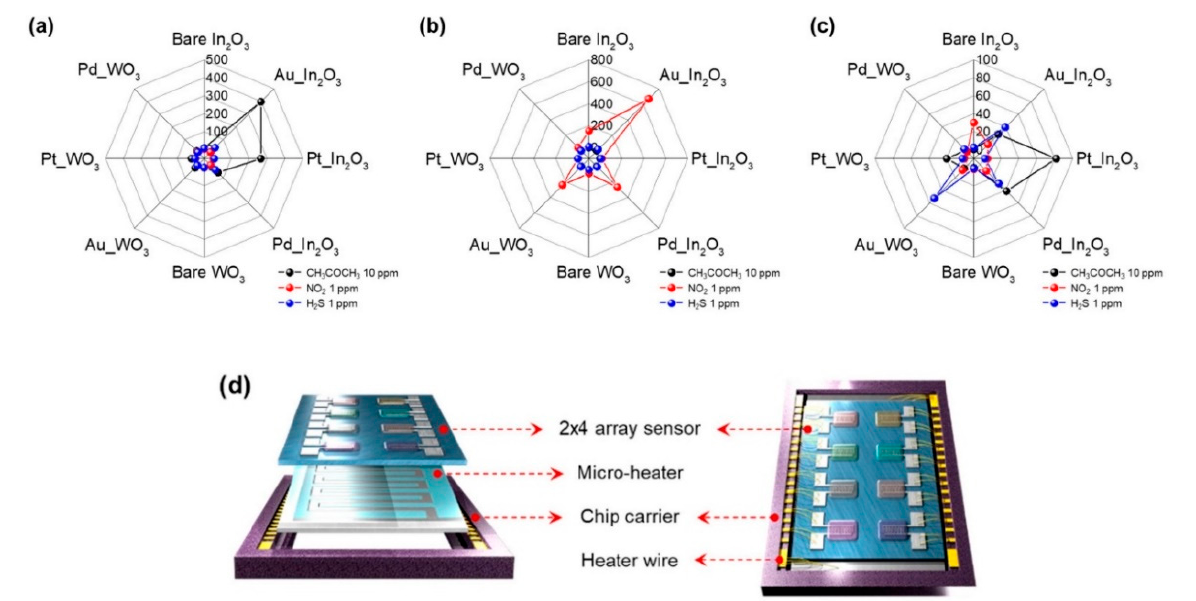
Figure 5. Polar plot of a 2 × 4 sensor array response for ( a ) 10 ppm of acetone; ( b ) 1 ppm of NO 2 and; ( c ) 1 ppm of H 2 S and operation temperatures 300, 150, and 250 °C; ( d ) schematic representation of the parts of the sensor (2 × 4 sensor array, back heater, chip carrier, and Au wires). The array shows good recovery and repeatability as well as high performance at sub ppb level, facilitating discrimination between the three biomarkers. Adapted with permission from Ref. [99]. Copyright © 2021 by the authors. Licensee MDPI, Basel, Switzerland.